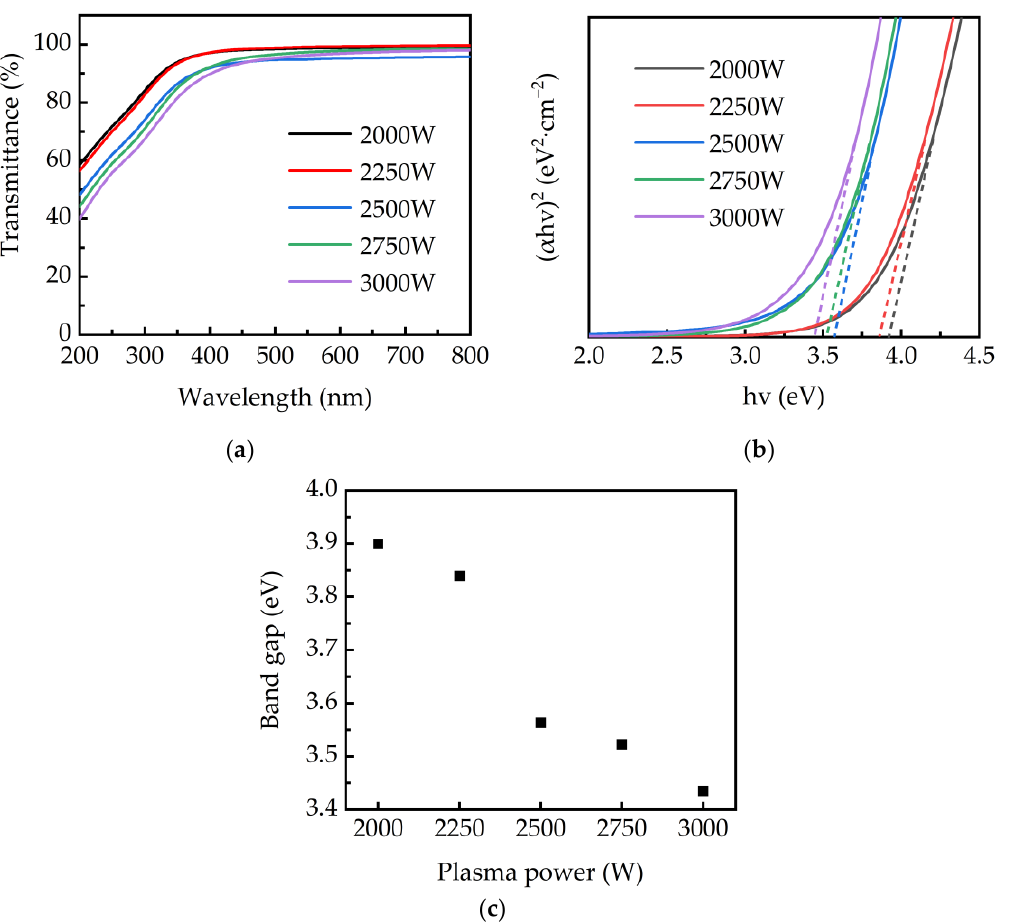
Figure 9. ( a ) Transmittance spectra of the PEALD-GaN deposited at various plasma powers. ( b ) The plot of ( α hv) 2 as a function of photon energy (hv). ( c ) The optical bandgap of the PEALD-GaN films.